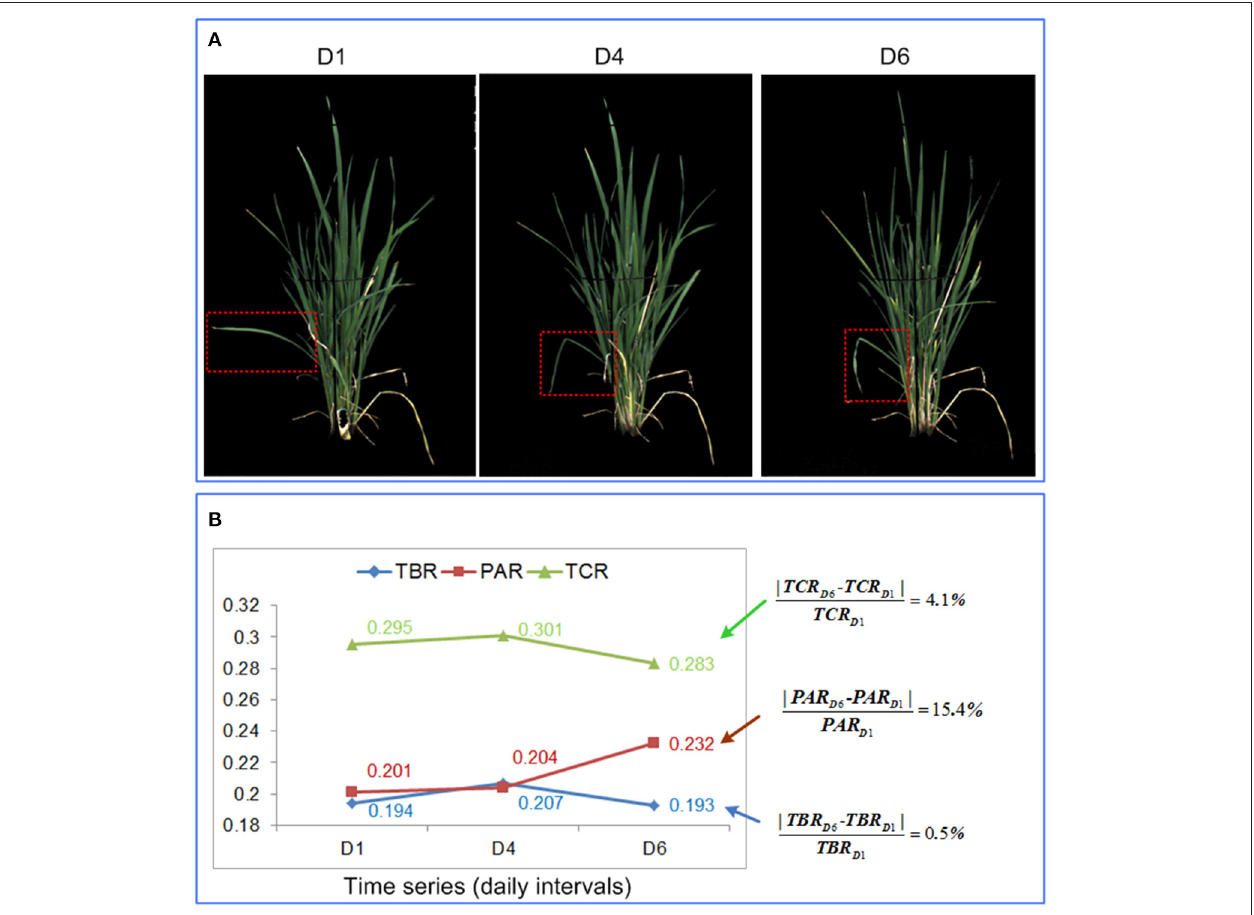
FIGURE 6 | Comparison of the 3 shape descriptors in quantification of leaf-rolling. (A) RGB image at day 1, day 4, and day 6 for a rice plant. (B) Values of the 3 shape descriptors at day 1, day 4, and day 6, with the percentage change in each feature provided to the